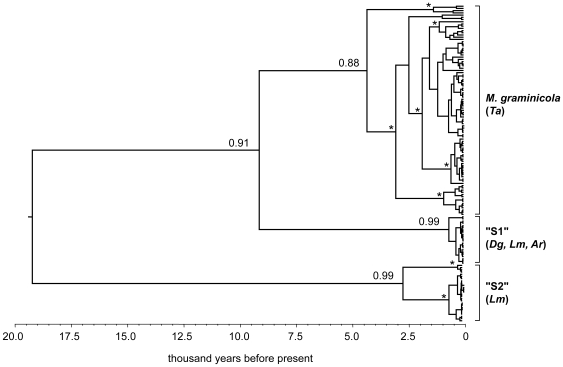
Phylogenetic relationships among fungal samples from different hosts.Maximum clade credibility (MCC) tree from Bayesian coalescent analysis depicting the phylogenetic relationships among fungal samples collected from domesticated bread wheat (Ta, Triticum aestivum) and wild grasses (Ar, Agropyron repens; Dg, Dactylis glomerata; Lm, Lolium multiflorum). Clade-credibility values are shown only for the three major lineages. Asterisks denote nodes within lineages that received >90% posterior support.